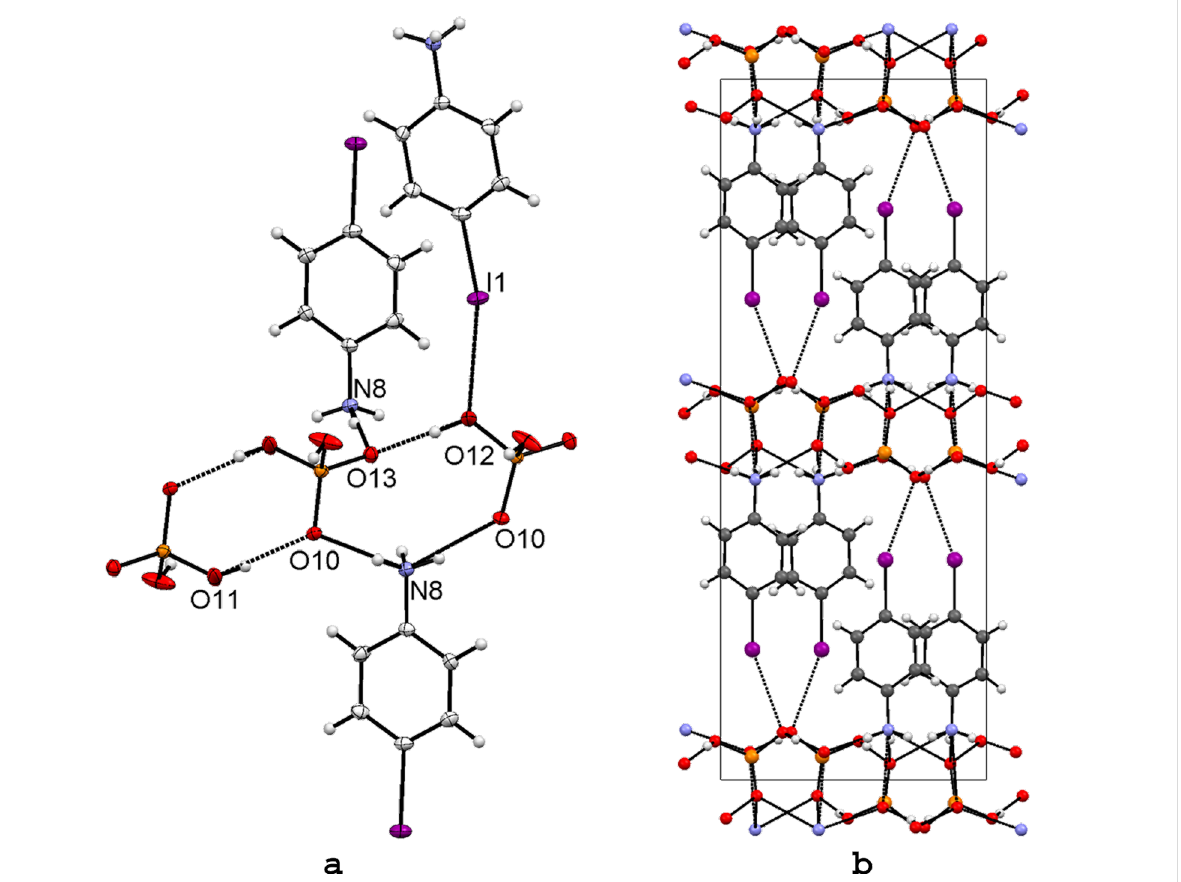
Figure 4: X-ray structure of 4-IPhNH 3 H 2 PO 4 ( 6 ) with selected numbering scheme of the asymmetric unit and the packing scheme viewed down the a axis (b). Thermal ellipsoids are drawn at the 50% probability level. Hydrogen and halogen bonds are shown in dotted lines.